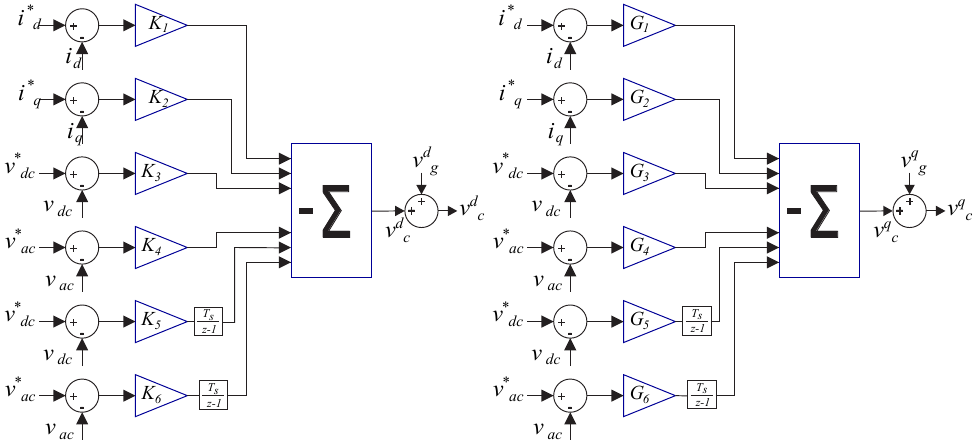
Figure 3. Data-driven controller for a VSC-based STATCOM